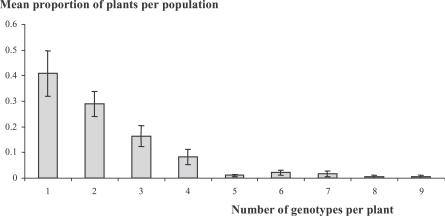
Mean Proportion of Plants per Population Having a Given Number of Fungal GenotypesBars indicate standard errors.